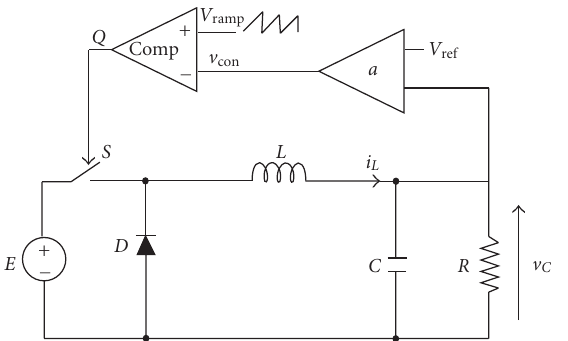
Figure 1: Voltage-mode controlled buck